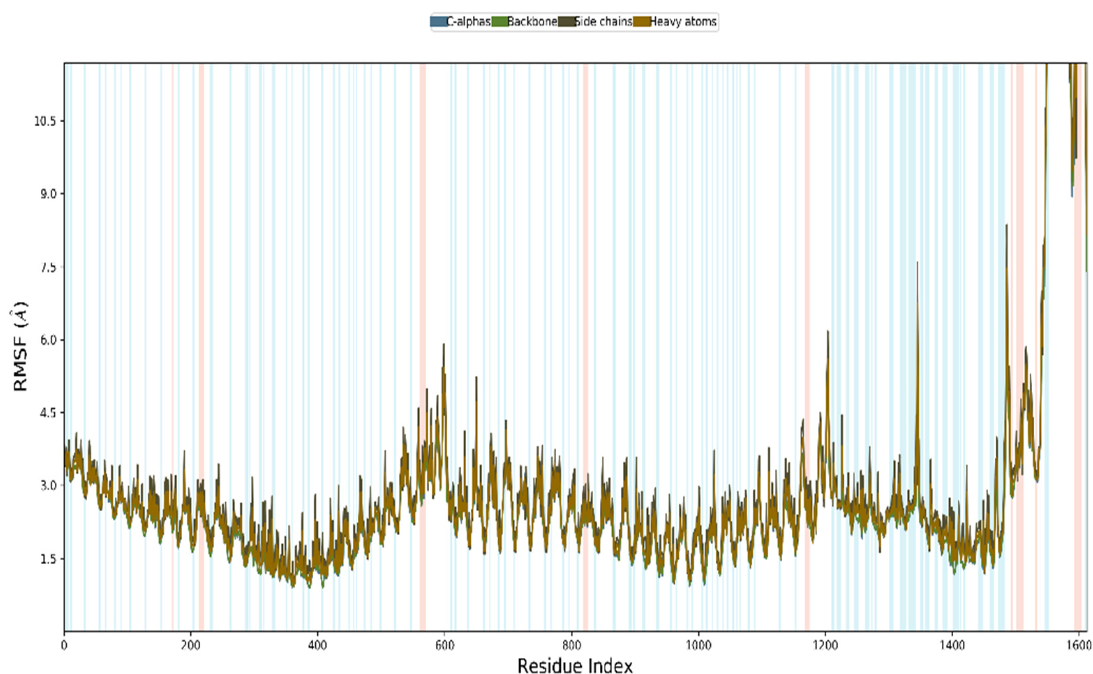
Figure 10. The multi-epitope vaccine complex is simulated. A multi-epitope docked vaccine candidate is shown in the RMSF figure. Red and blue backgrounds, respectively, emphasize the alpha-helical and beta-strand portions. These places are identified by helixes or strands that last for 70% of the simulation time.